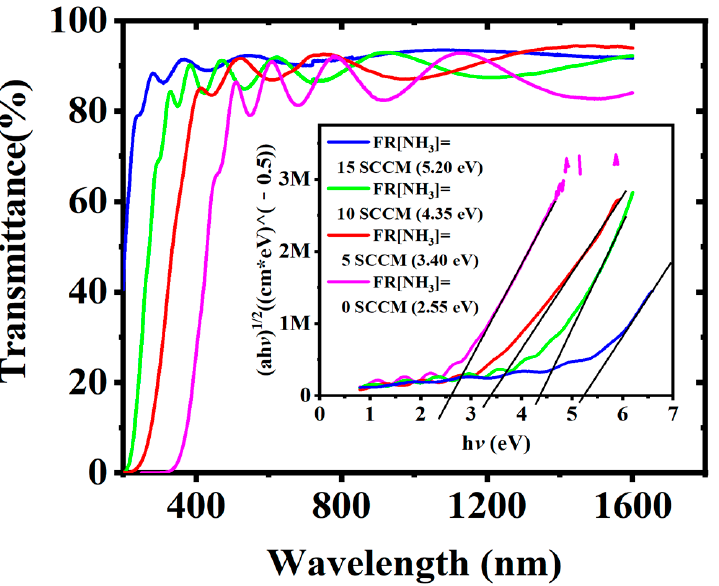
Figure 2. PL spectra acquired from the pristine CsPbBr 3 QD film and CsPbBr 3 QDs/a-SiC x N y :H nano- composite thin films prepared with different NH 3 flow rates: ( a ) 15 SCCM; ( b ) 10 SCCM; ( c ) 5 SCCM; ( d ) 0 SCCM, respectively.